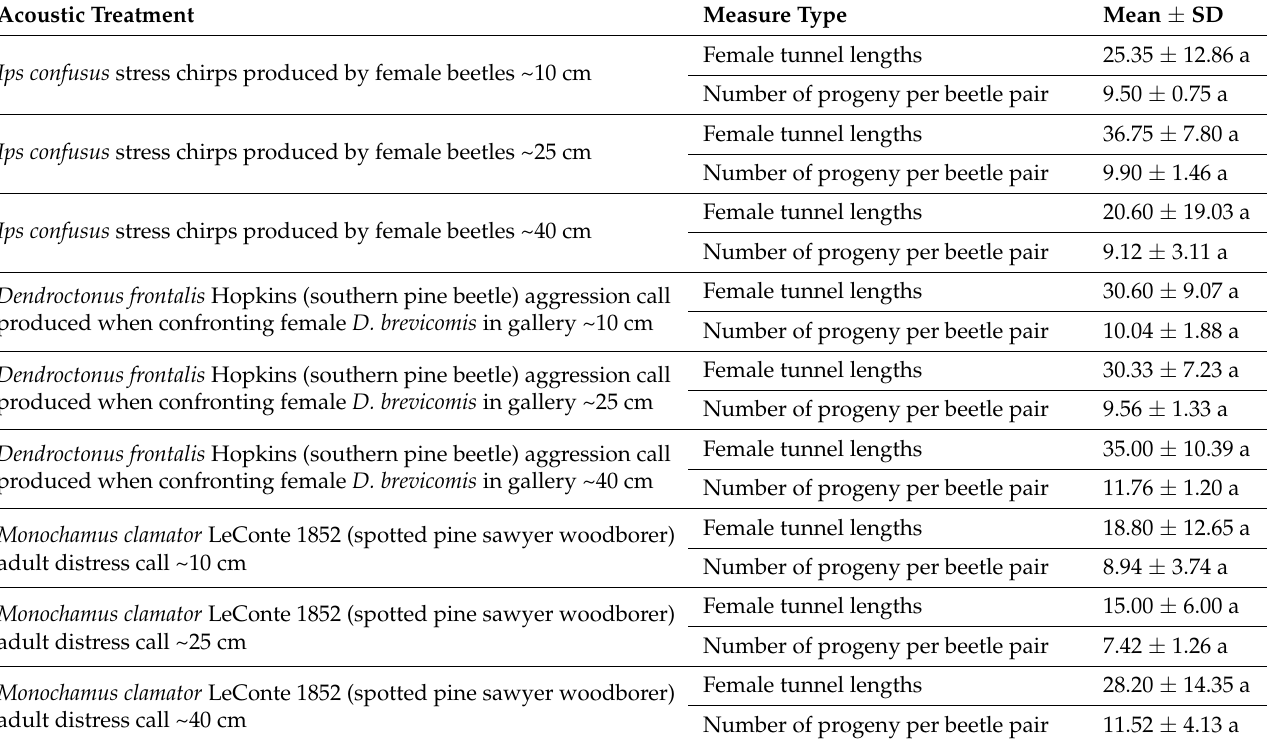
Table A1. Post hoc statistical analysis (Tukey HSD test) of measured variables (Mean ± SD) between acoustic treatments. Letter “a” represents statistically not significant difference between acoustic treatment groups or lengths on the log (female tunnel lengths: Welch’s ANOVA–F 11, 15.18 = 2.789, p = 0.033 *; number of progeny per beetle pair: one-way ANOVA: F 1,11 = 1.52, p =